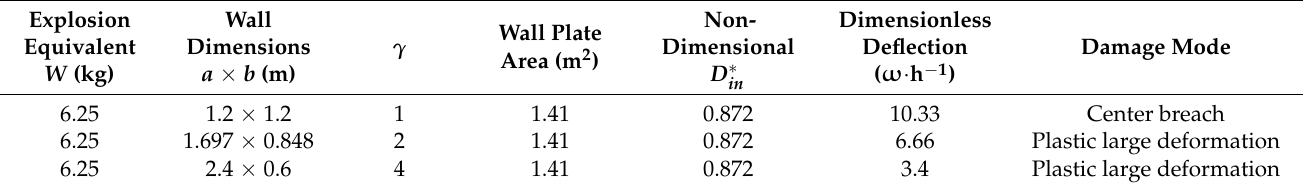
Table 7. The damage features of the same area & different aspect ratios of the wall